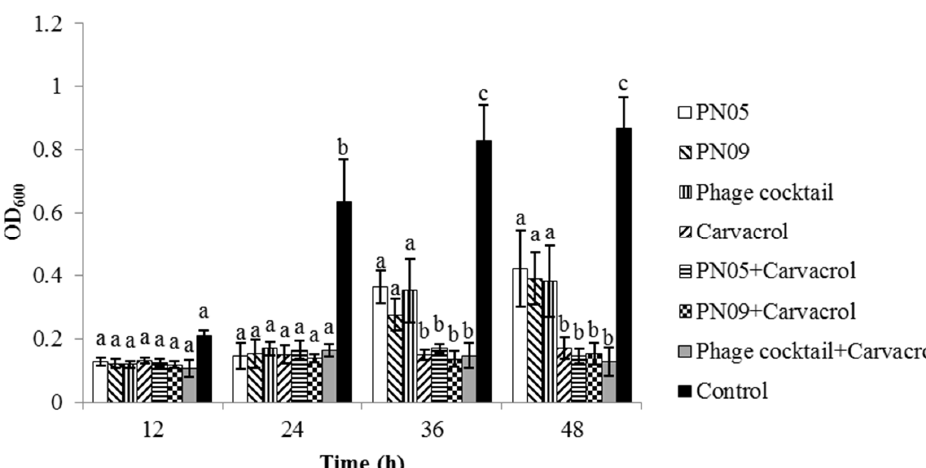
Figure 6. Efficacy of phages (PN05, PN09 and phage cocktail) and 2 mg/mL carvacrol in preventing Psa biofilm formation by Psa (SCJY02-1) after 12 h, 24 h, 36 h or 48 h. Di ff erent letters in the column at the same time point (12 h, 24 h, 36 h or 48 h) indicate a statistical di ff erence ( p < 0.05). Y-axis means the